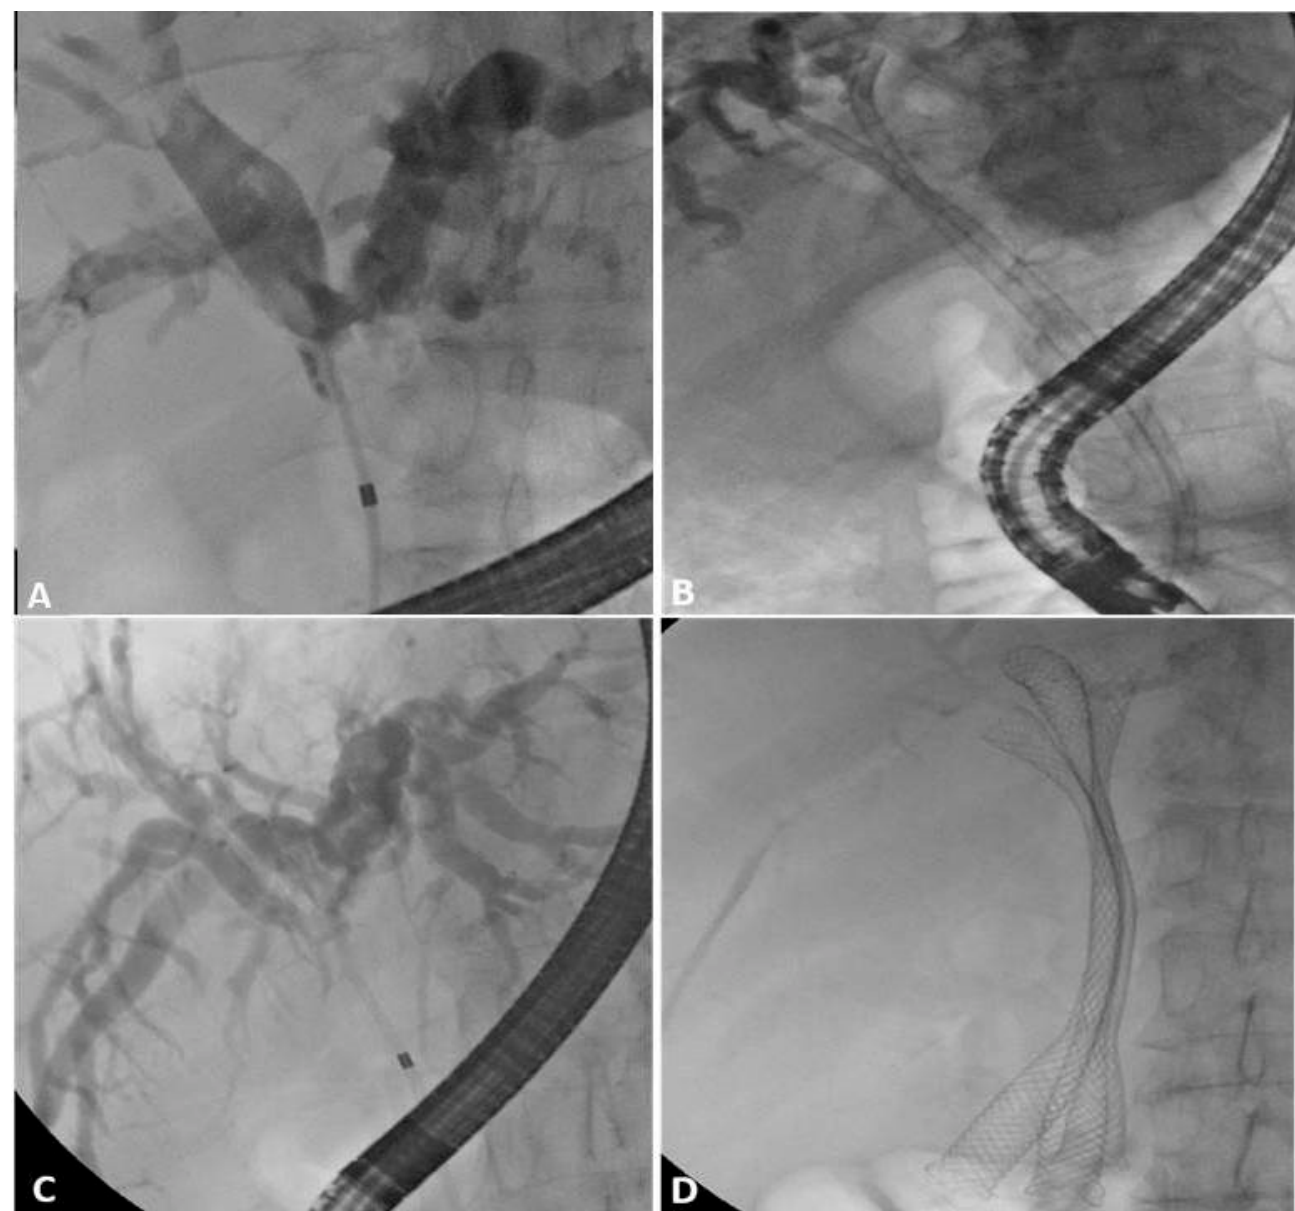
Figure 5. ( A ) Bismuth type II malignant hilar stricture ( B ) drained with two plastic stents. ( C ) Bismuth type IIIa malignant hilar stricture ( D ) drained with three self-expandable metal stents.